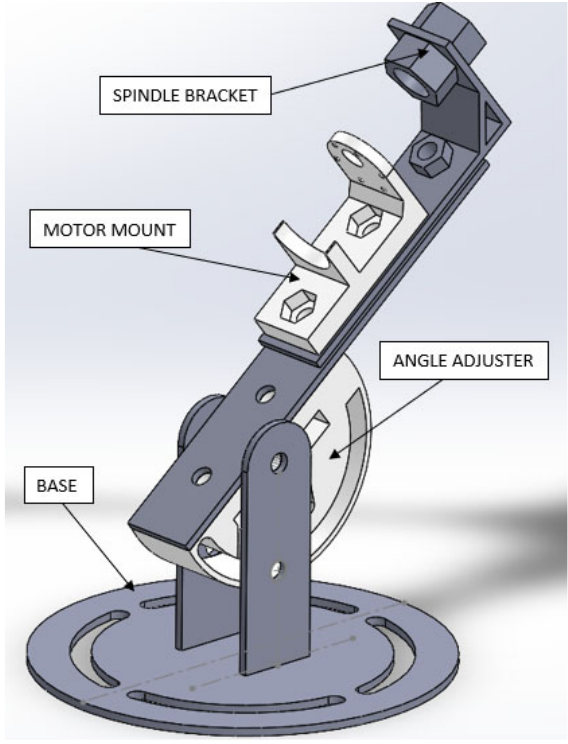
Figure 10. Support